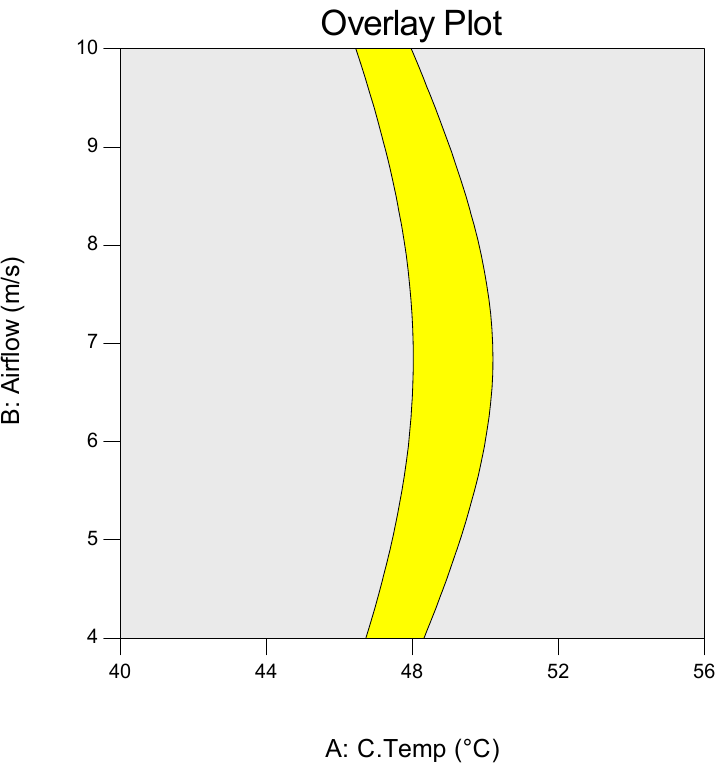
Figure 5. Optimum region with the highest software estimated dewatering efficiency.